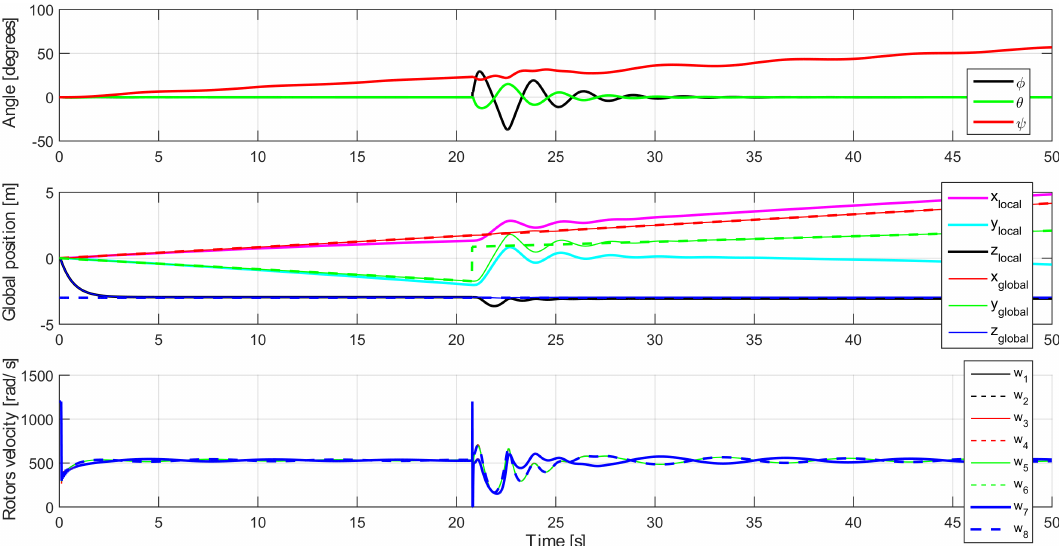
Figure 9. Results of experiment no. 2. From above: Euler’s angles, positions (in X , Y , Z ∈ BF and in x , y , z ∈ EF coordinates) and rotors velocity for simulated